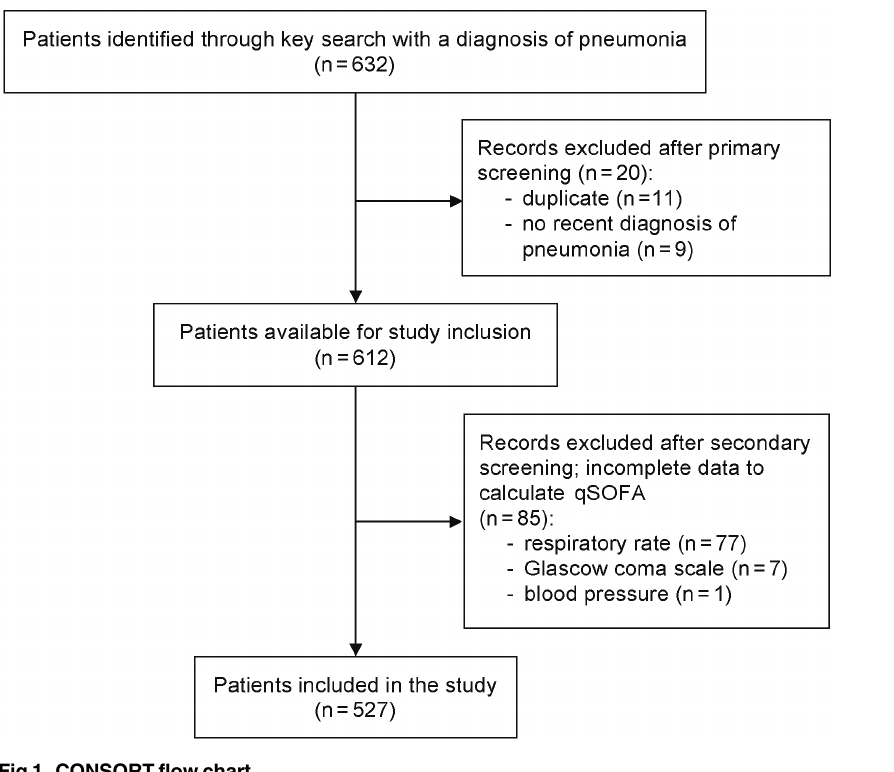
Fig 1. CONSORT flow